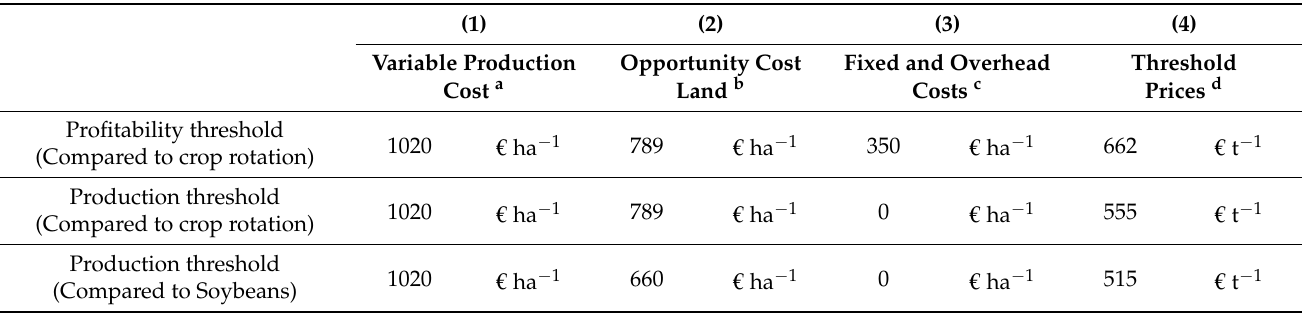
Table 4. Threshold prices for white lupin